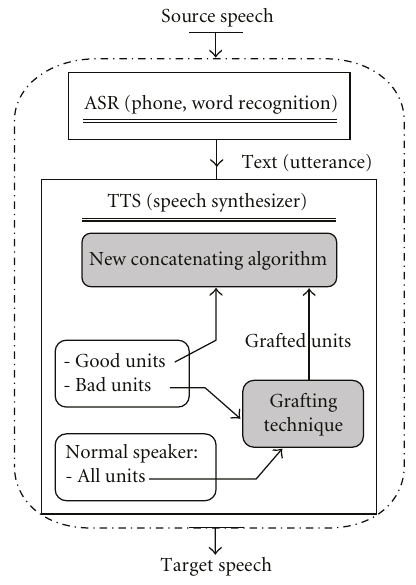
Figure 1: Overall system designed to help both dysarthric speakers and those with SSD.